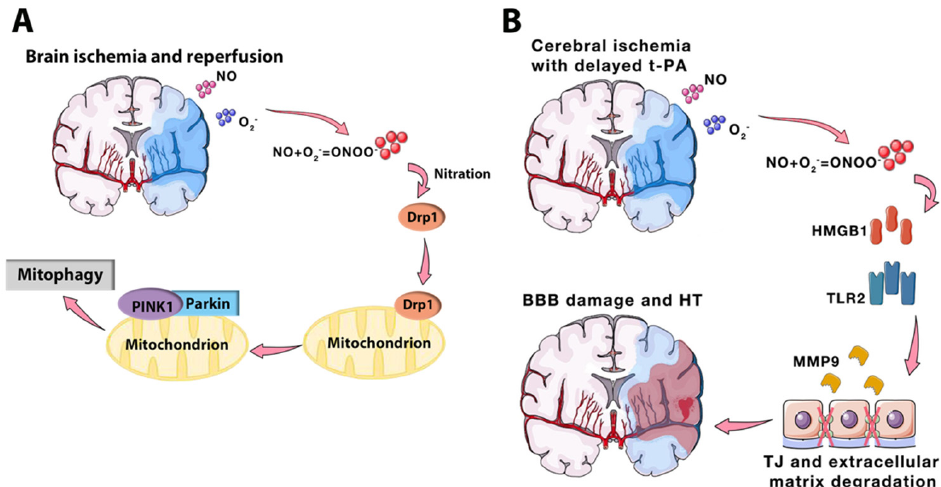
Figure 3. Effects of peroxynitrite in brain I/R. ( A ) In brain I/R, peroxynitrite produced during the reperfusion stage facilitates the recruitment of Drp1 via nitration to initiate PINK1/Parkin-mediated mitophagy, which may contribute to brain I/R injury [48]. ( B ) Another model of brain I/R is cerebral ischemia with delayed t-PA treatment, which facilitates the production of peroxynitrite. HMGB1 is activated by peroxynitrite and then upregulates the expression of MMP9 via TLR2, resulting in BBB disruption and HT [64,65]. HMGB1, high mobility group box 1 protein; TLR2, toll-like receptor 2; MMP 9, matrix metalloproteinase 9; TJ, tight junction; HT, hemorrhagic transformation; Drp1, dynamin-related protein 1; PINK, PTEN-induced kinase; BBB, blood brain barrier. Reproduced with